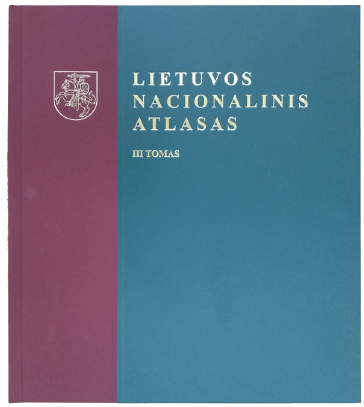
Fig. 1. Cover of Volume III of the